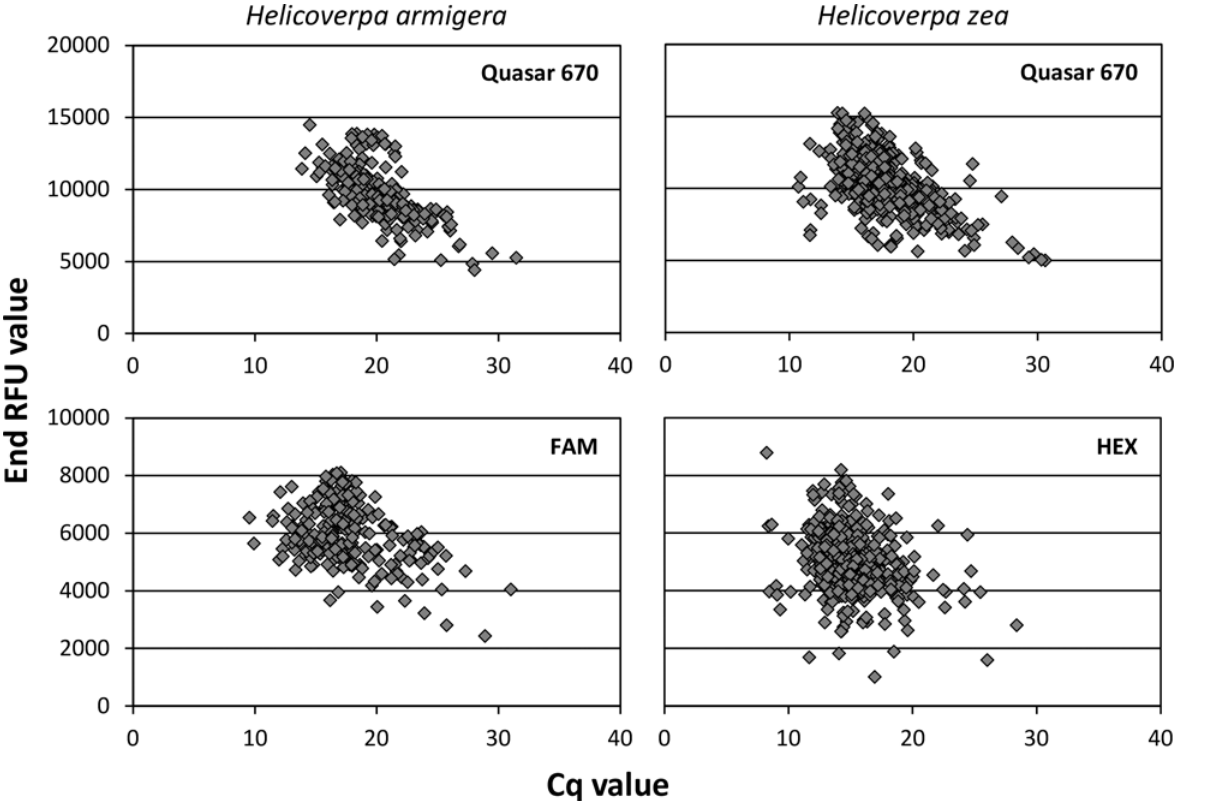
Fig 2. Cq values plotted against end RFU values for each probe in the triplex real-time PCR assay.